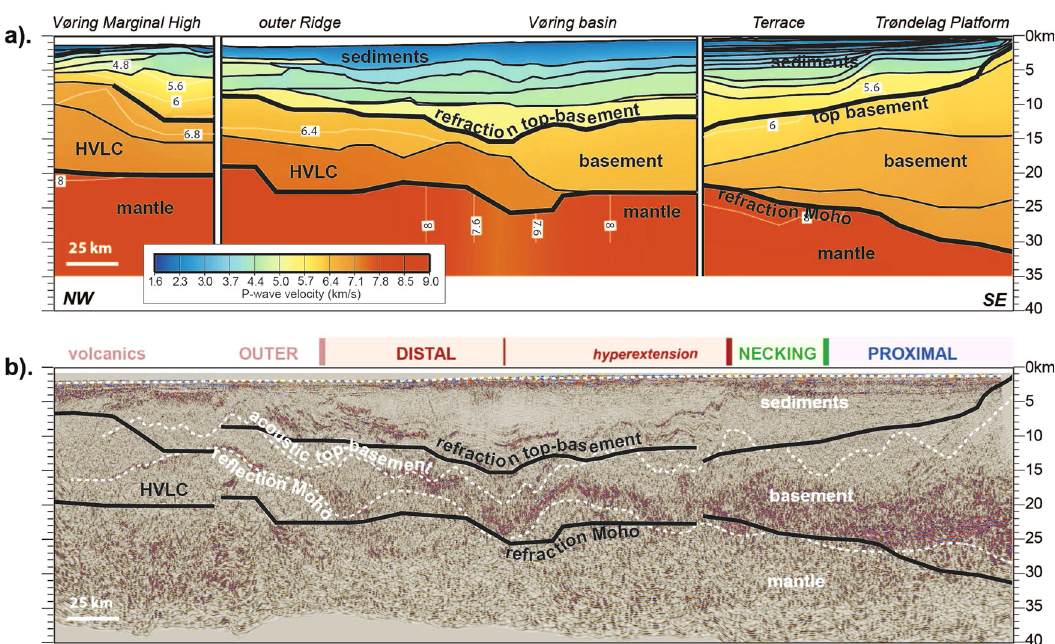
Fig. 3 Comparison between seismic refraction and seismic re fl ection Mohos. a Composite seismic refraction pro fi les remodeled and compiled by Funck et al. 48,49 . The original models are issued from: right-hand segment: the OBS2003 Line 3 from Breivik et al. 50 , middle segment: the Vøring96 Line 10 from Raum et al. 52 , left-hand segment: the OBS2003 Line 11 from Breivik et al. 51 . b Depth converted seismic re fl ection pro fi le selected as representative of the global architecture of the Norwegian Continental Shelf. Same as in Figs. 1b and 2a. See Fig. 1 for location. The top acoustic basement and seismic re fl ection Moho are outlined with thin dashed white lines. The refraction top basement and Moho modeled based on wide-angle data are displayed with thick black continuous lines. HVLC high-velocity lower